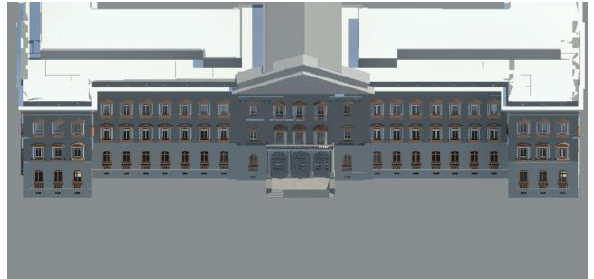
Figure 11. Naples Front of the Federico II building on corso Umberto I. 3D model